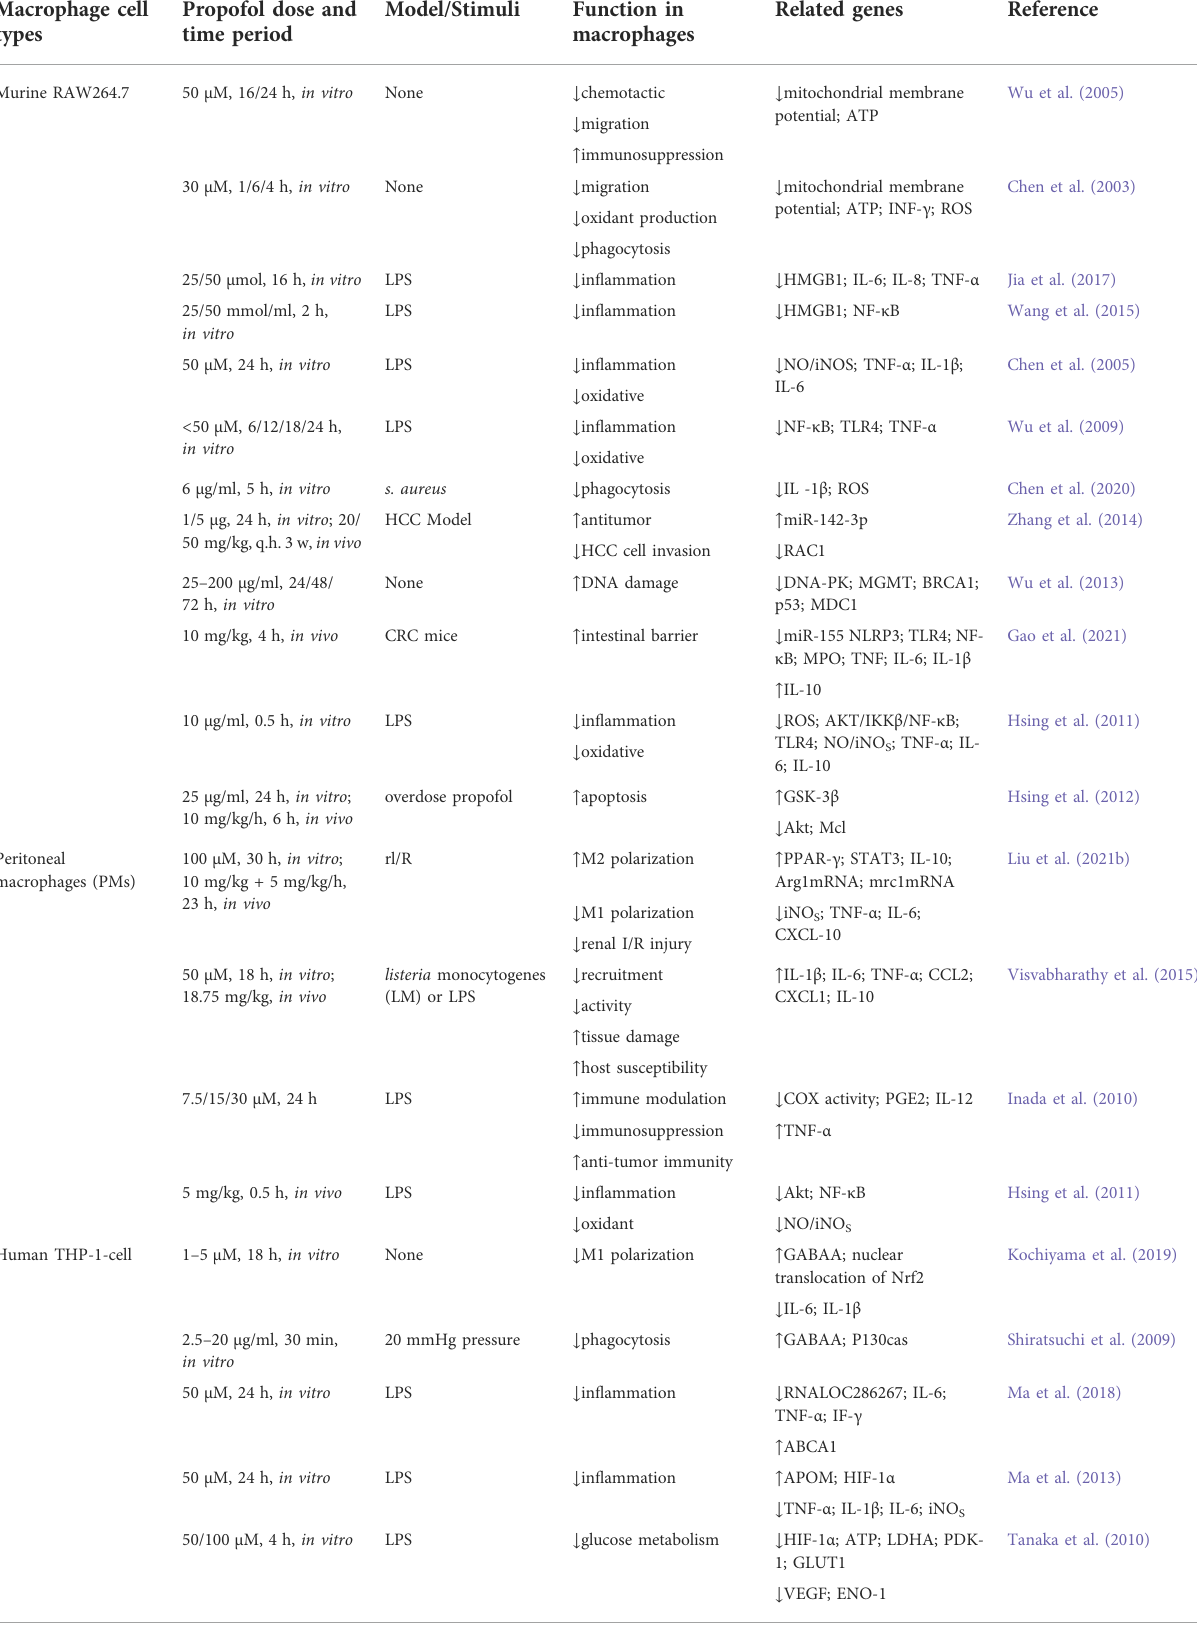
TABLE 1 Regulation of propofol on macrophage activation and